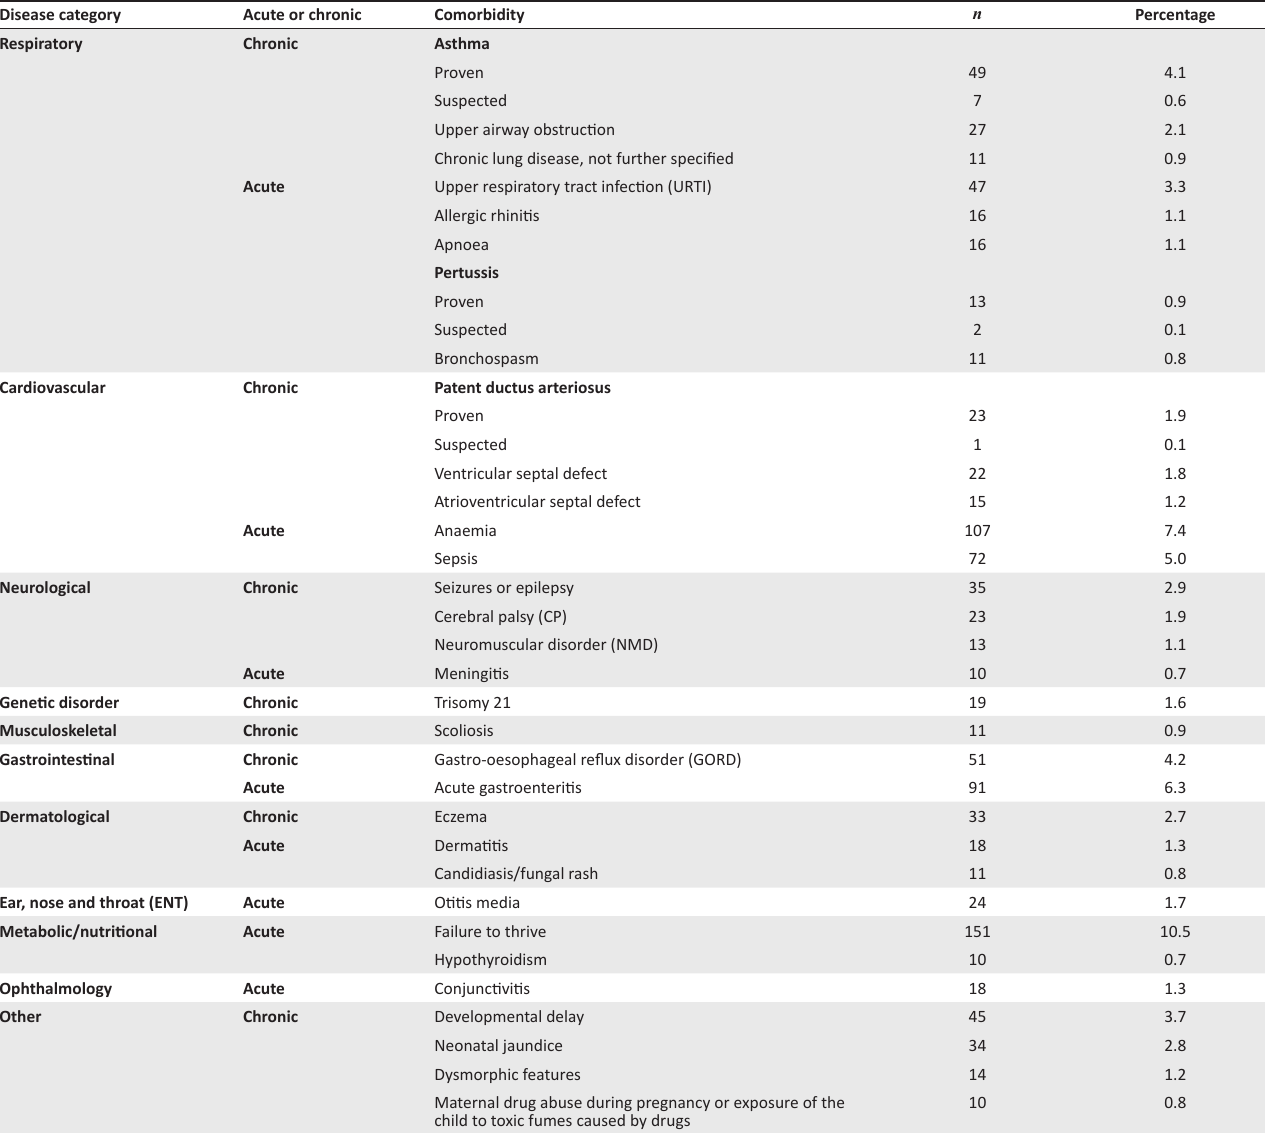
TABLE 3: Most common chronic (based on n = 1208 children) and acute ( n = 1440 hospitalisations) comorbidities seen in children hospitalised with a lower respiratory tract infection. Disease